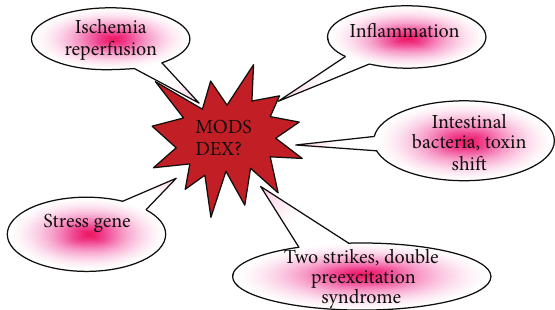
Figure 2: There have been several hypotheses regarding the mechanism of MODS (Figure 2), including ischemia reperfusion, inflammation, intestinal bacteria, toxin shifts, two strikes double preexcitation syndrome, and stress